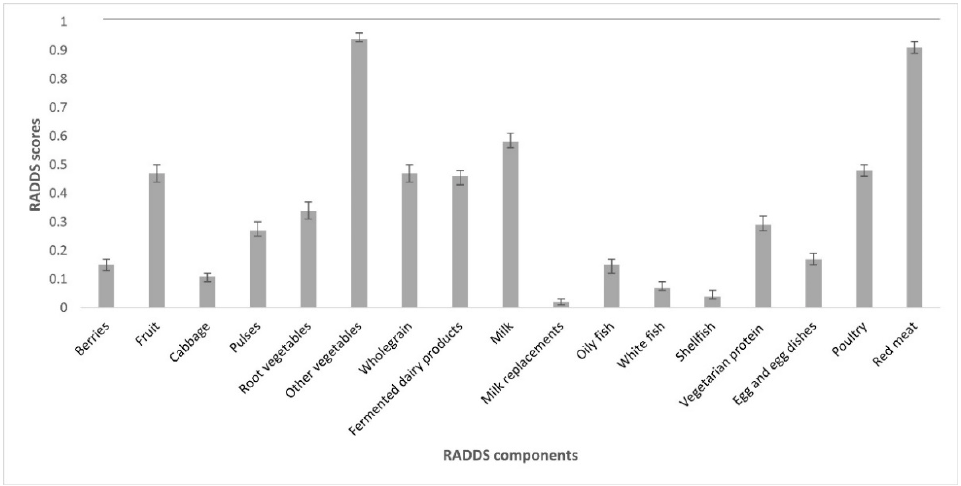
Figure 2. Mean scores for the Riksmaten Adolescents Diet Diversity Score (RADDS) scores for each component as compared with the RADDS reference value. Error bars = 95% confidence intervals, reference value = 1 for acquiring a RADDS score of 0.